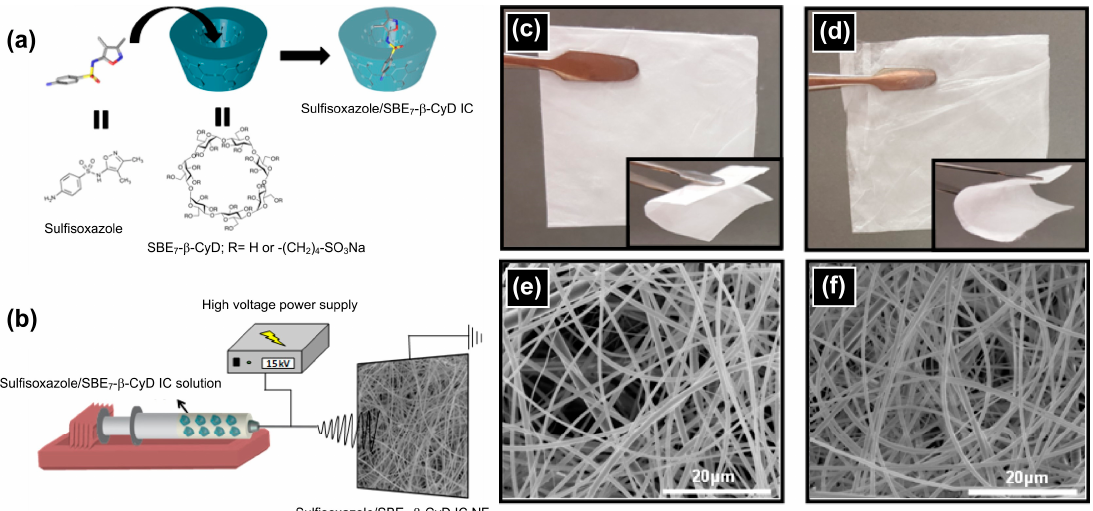
Figure 6. ( a ) Cartoon illustration of inclusion-complexation between CyD and sulfisoxazole (SFS). The chemical structure of sulfisoxazole and SBE 7 - β -CyD with a schematic representation of sulfisoxazole, SBE 7 - β -CyD and their IC, ( b ) schematic representation of the electrospinning of SFS/SBE 7 - β -CyD-IC NF. Photographs of electrospun ( c ) SBE 7 - β -CyD nanofibers, ( d ) SFS/SBE 7 - β -CyD-IC nanofibers, and SEM images of ( e ) SBE 7 - β -CyD NF, ( f ) SFS/SBE 7 - β -CyD-IC nanofibers. The figure was reproduced from [179] with the permission of Elsevier, 2017.